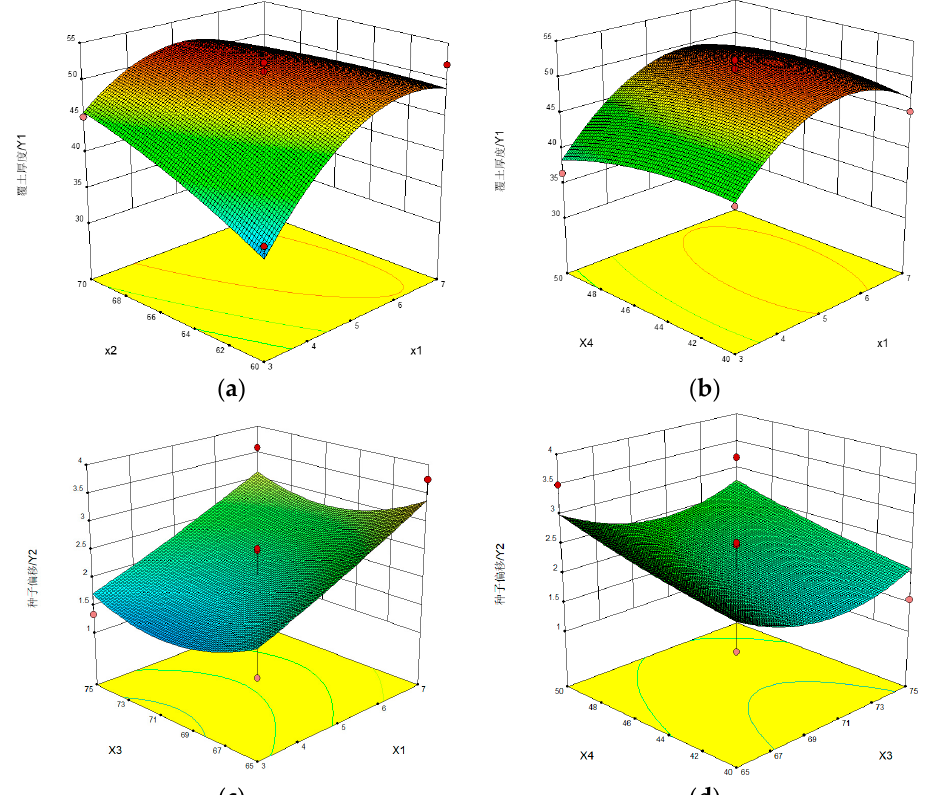
Figure 13. The interaction between the factors affects the response surface of the test index: ( a ) x3 and x4 are 70 ◦ and 45 ◦ , respectively, the relationship between the thickness of the covering soil and X1 X2; ( b ) X2 and X3 are 65 ◦ and 70 ◦ , respectively, the relationship between the thickness of the covering soil and X1 X4; ( c ) 2 and X4 are 65 ◦ and 45 ◦ , respectively, the relationship between the seed offset and X1 X3; ( d ) X1 and X2 are 3 km · h − 2 and 65 ◦ , respectively, the relationship between the seed offset and X3 X4.